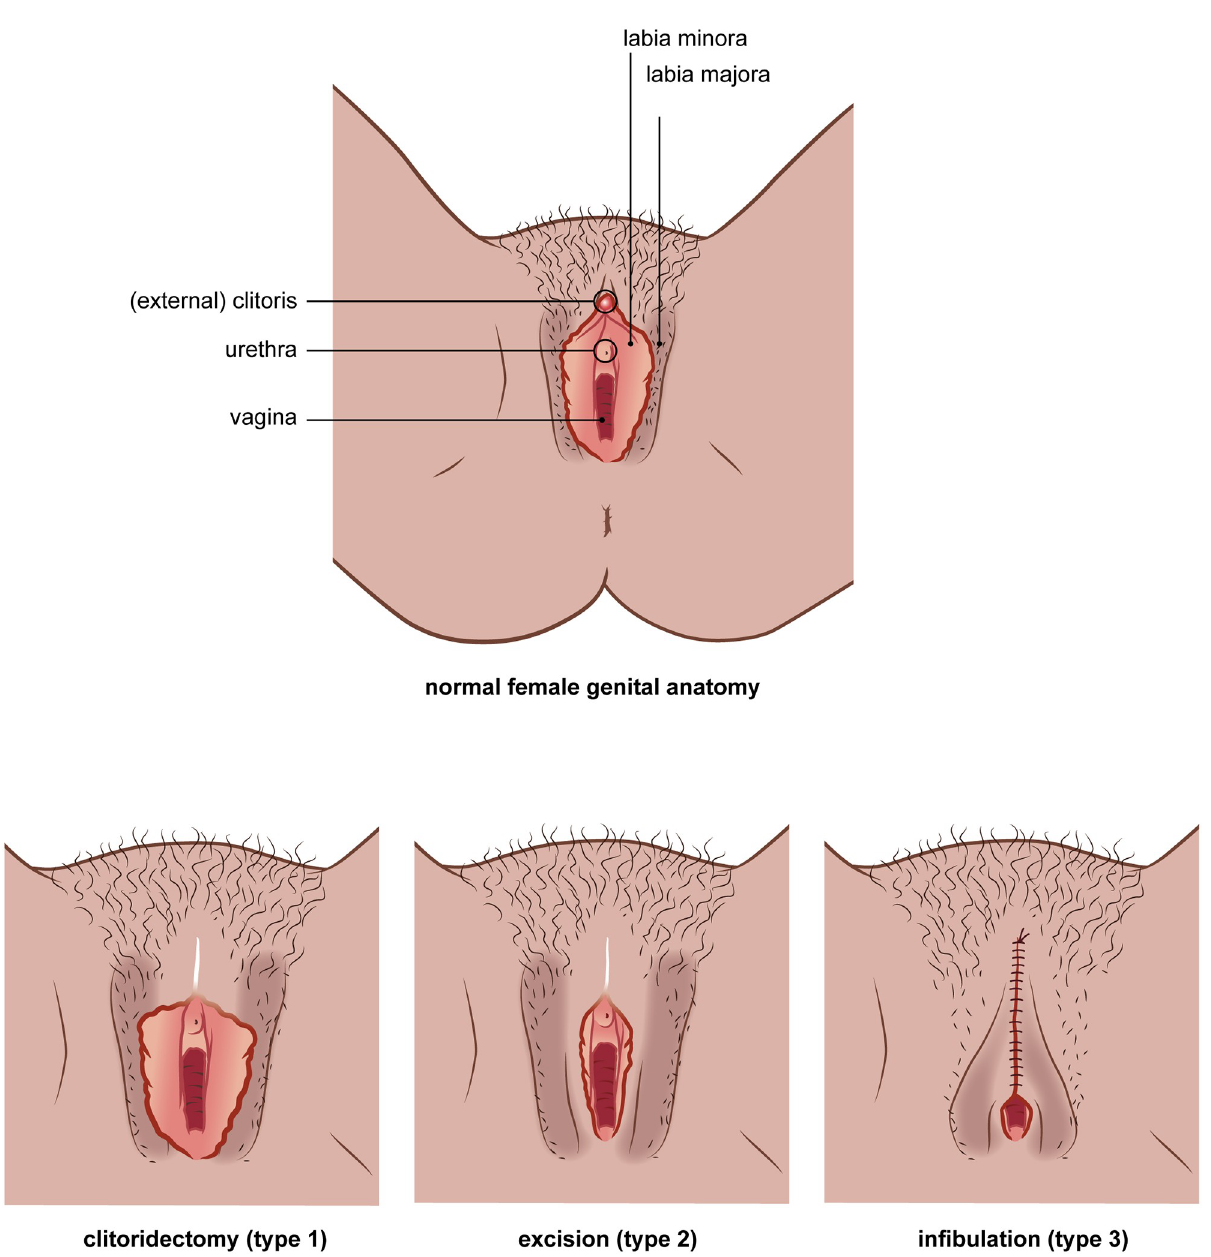
Fig 1. World Health Organization classification of female genital mutilation or cutting. Type I refers to excision of the prepuce, with or without excision of part or all of the clitoris. Type II refers to excision of the clitoris with partial or total removal of the labia minora. Type III refers to excision of part or all of the external genitalia and stitching or narrowing of the vaginal opening (infibulation). Type IV includes all other harmful procedures to the female genitalia for nonmedical purposes, e.g., pricking, piercing, incising, scraping and cauterizing the genital area [4, 5].